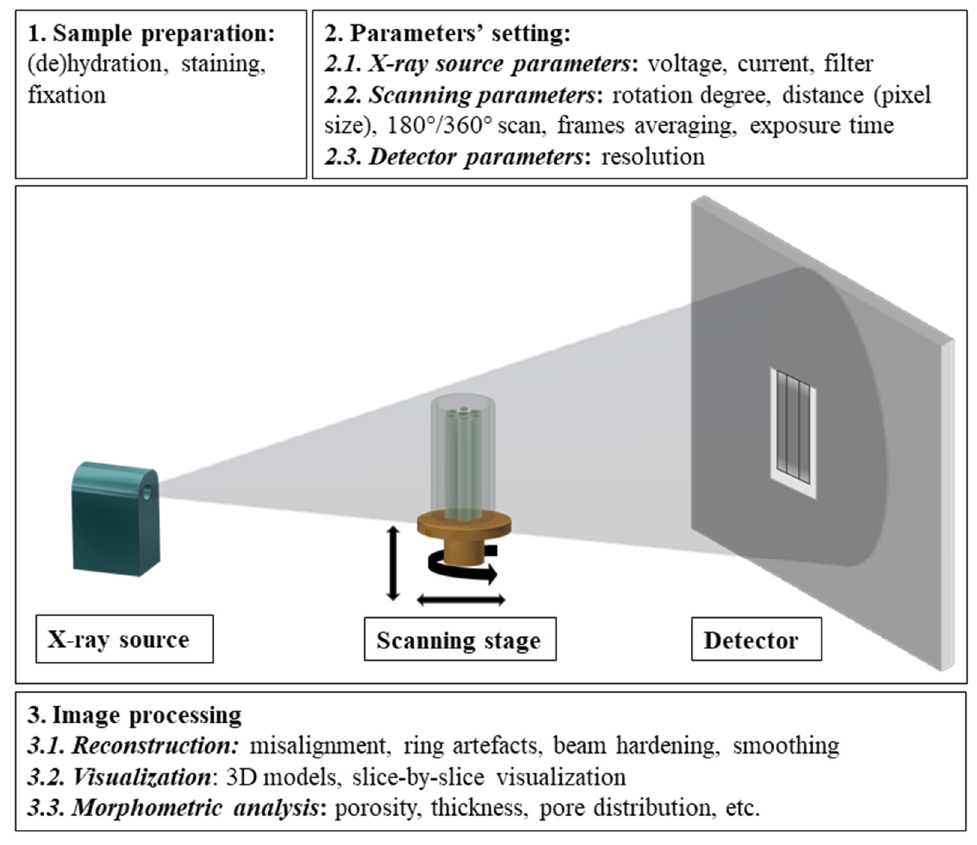
Figure 1. Laboratory CT working principle and main steps for data acquisition, reconstruction, visualization, and analysis.